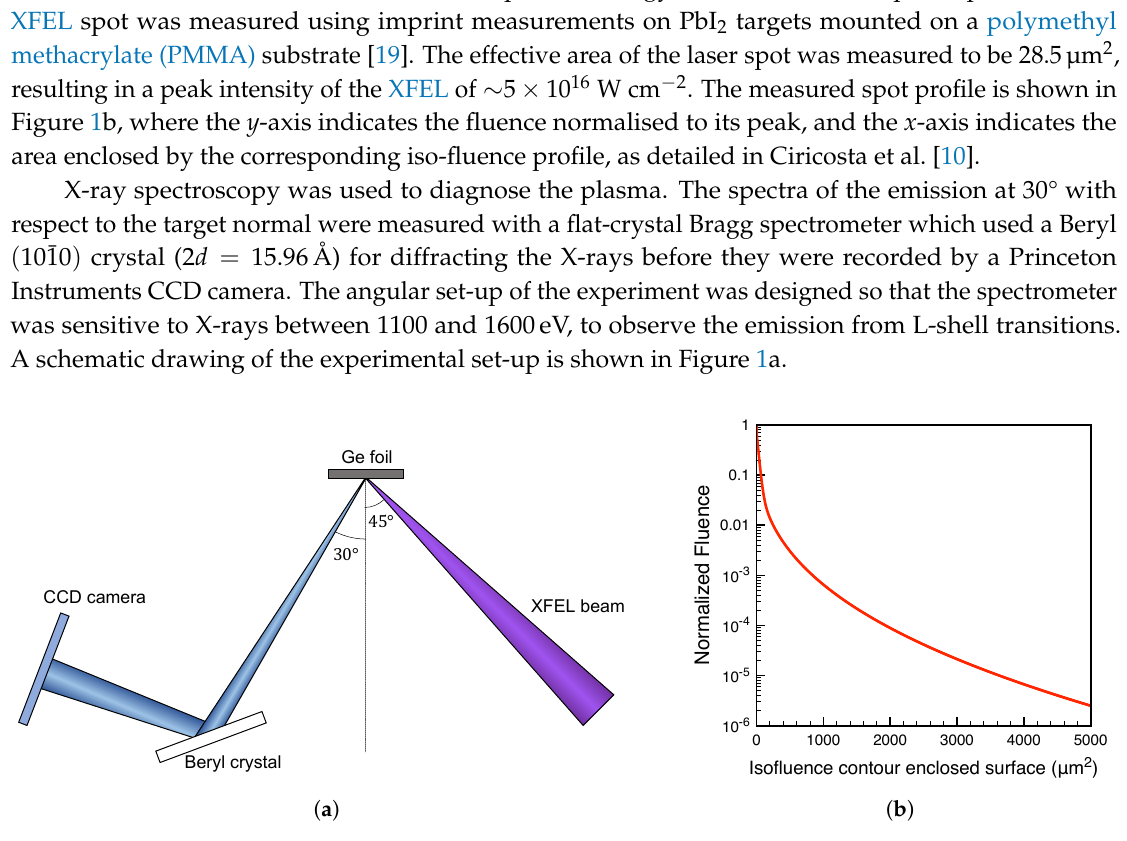
Figure 1. ( a ) Schematic drawing of the experimental set-up. The X-ray free electron laser (XFEL) beam impinges upon the Ge foil at a 45° angle. The X-rays emitted around 30° with respect to (w.r.t.) the target normal are then diffracted by a beryl crystal before reaching the CCD camera. ( b ) Fluence scan of the laser spot. The laser fluence is normalised to its peak, and the x -axis shows the area enclosed by the isofluence profiles, as detailed in Ciricosta et al.